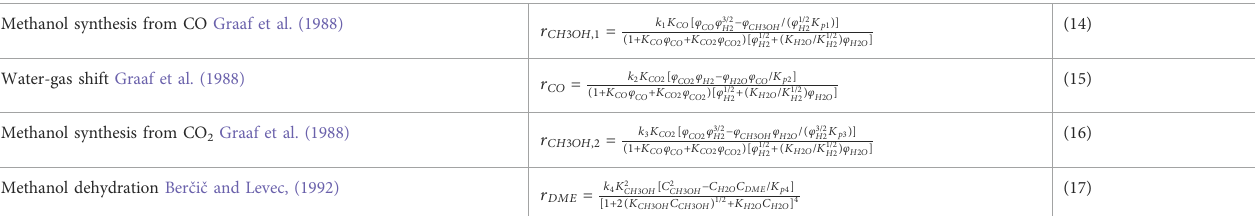
TABLE 2 Reaction rate equations.